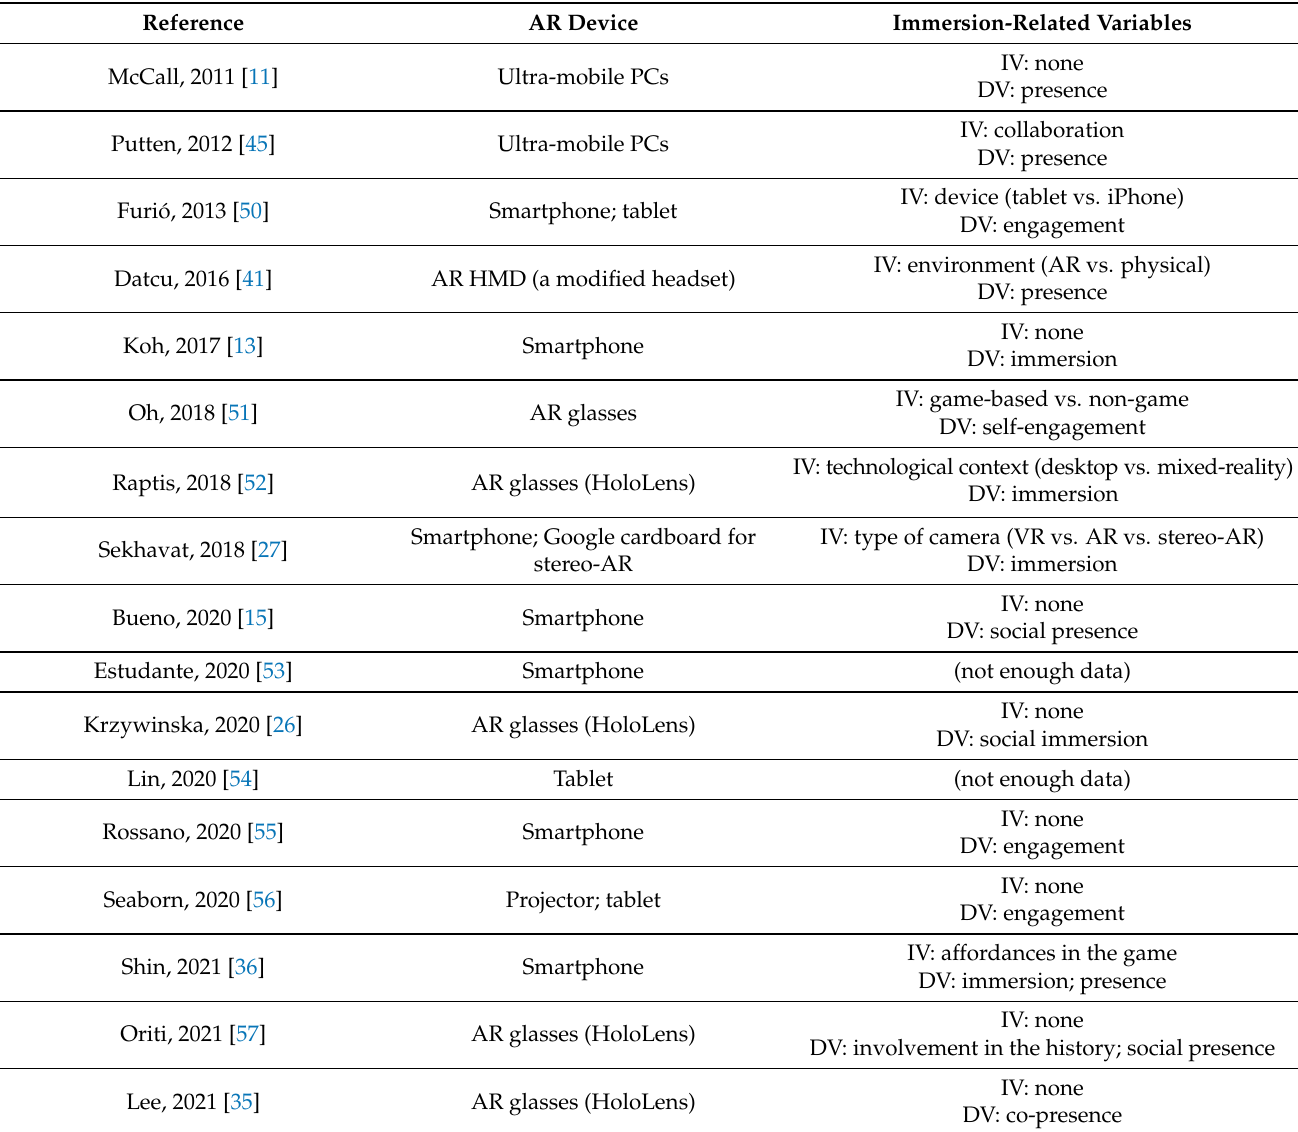
Table 4. List of the analysed studies presenting the devices used for the AR studies and the variables that were